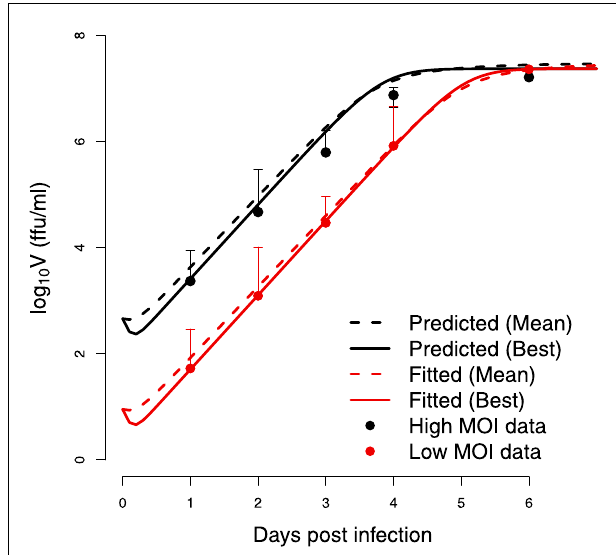
FIGURE 9 | Cross-validation. Test of estimated parameters on an independent set of data. The viral replication kinetics in wild-type Vero cells infected with EBOV at a high multiplicities of infection (MOI) in Halfmann et al. (2008) are modeled starting from a higher initial viral load of V 0 = 460 ffu/ml. The (Mean) indicates the predicted kinetics using parameters obtained from bootstrap while (Best) refers to the predicted kinetics using the parameters resulting from the